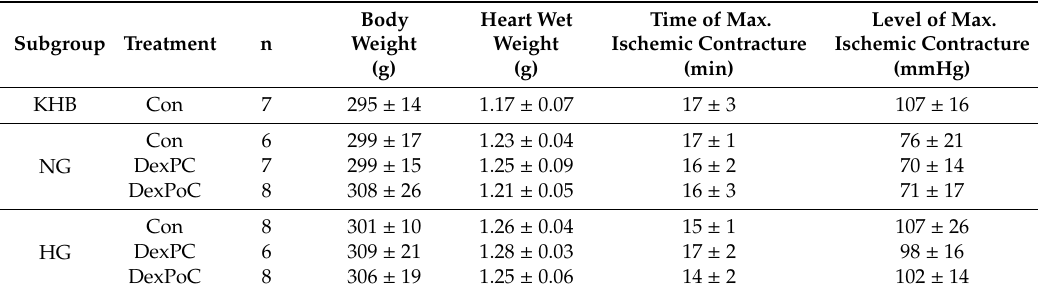
Table 1. Weights and ischemic